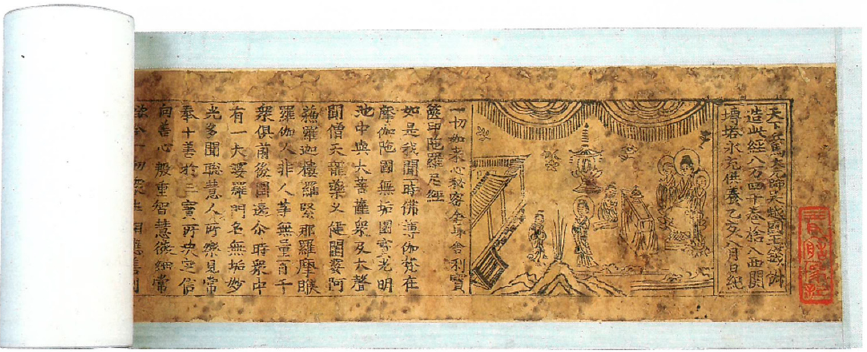
lapsed in 1924, numerous copies of the Kara ṇḍ amudr ā S ū tra were found in small holes in Figure 3. Detail of the Karan. d. amudr¯a S¯utra . Found inside the miniature iron st¯upa discovered in Shaoxing, Zhejiang Province, China. 965 CE, Wuyue (907–978). Xylograph; ink on paper. H. 8.5 cm; L. 182.8 cm. Zhejiang Provincial Museum. After (Li 2009b, p. 13).